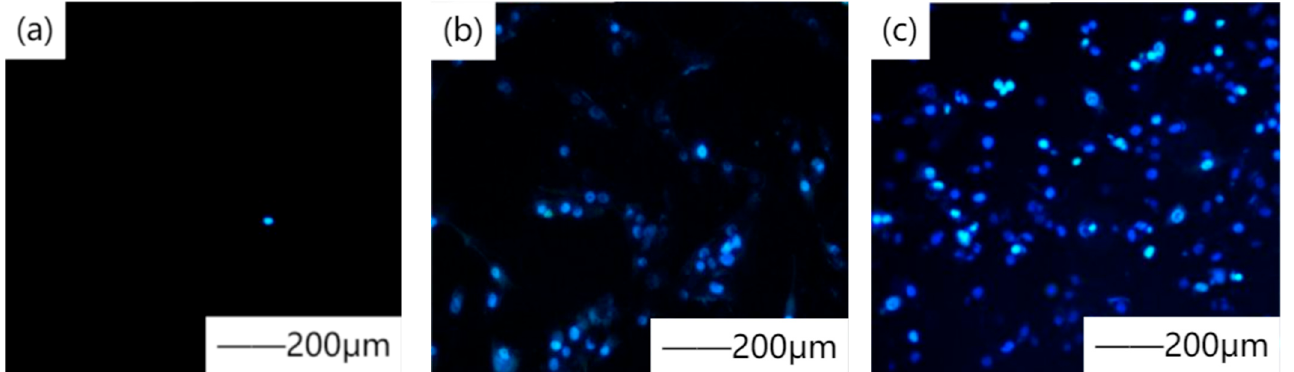
Figure 5. SEM analyses of ( a ) uncoated AZ31, ( b ) Nb2O5 coated AZ31 substrate. Reprinted with permission from Ref. [55]. Copyright 2014 Copyright Elsevier.